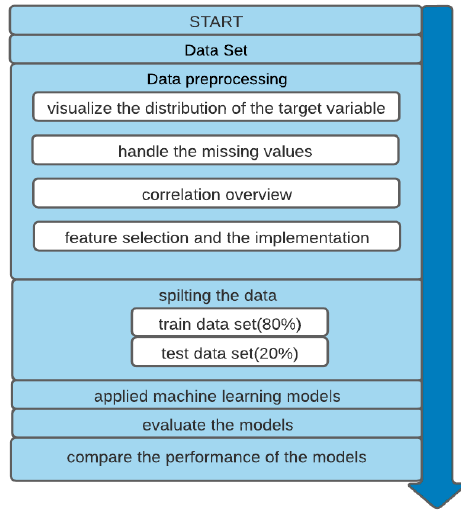
Figure 4. Overall structure of the proposed model.